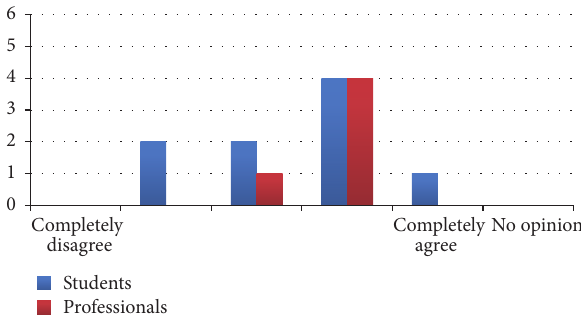
Figure 14: Statement: ECW/PUEA is a very useful method during product development.